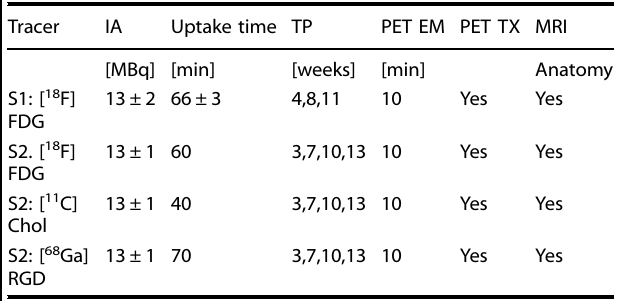
Table 2. Tracer uptake times and injected